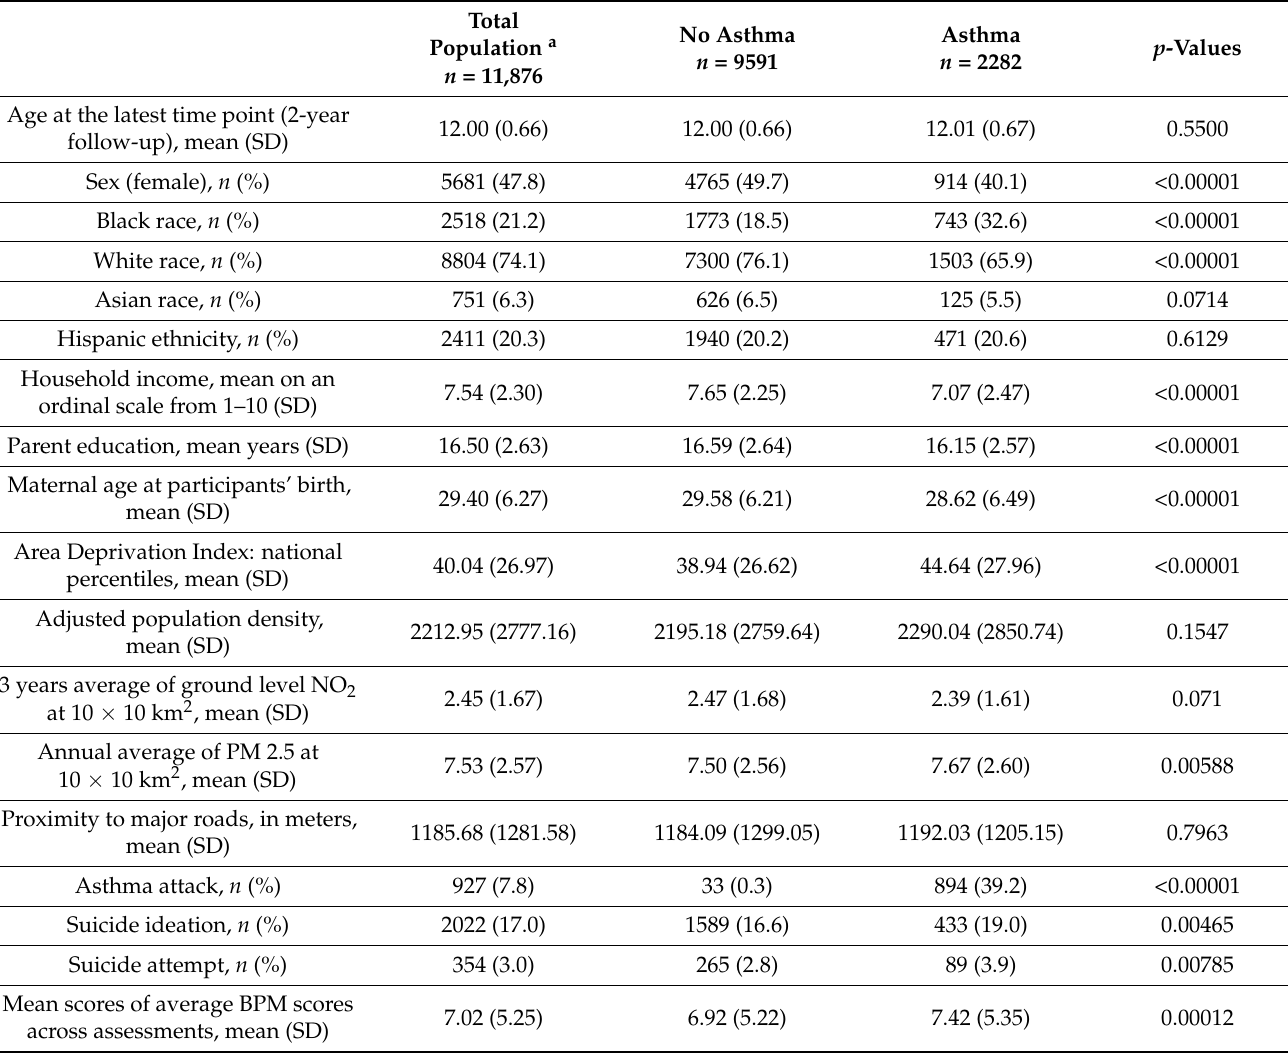
Table 1. Sample statistics for sociodemographics, asthma, and suicidality prevalence in the ABCD